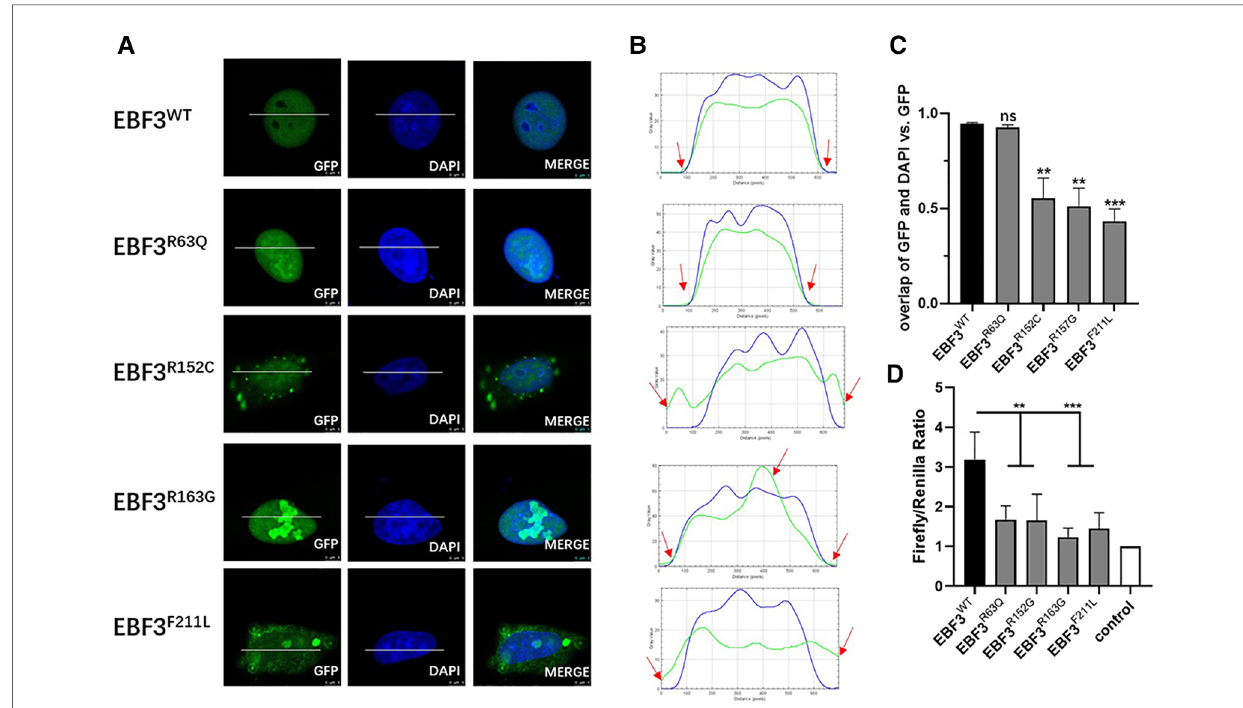
FIGURE 3 In vitro functional analysis of four novel missense variants at the cellular level. ( A ) Localization of GFP-EBF3-WT and GFP-EBF3-Mut (R63Q, R152C, R163G and F211L) in Hela cells. ( B ) Intensity pro fi les of GFP-tagged EBF3 wild-type and mutants and the DNA-binding dye, DAPI. The horizontal coordinate represents the pixels on the white lines drawn in A. The vertical coordinate represents the fl uorescence intensity of the pixel. The green curve represents the intensity pro fi le of GFP-EBF3, and the blue curve represents the intensity pro fi le of DAPI. For each condition a representative image and the corresponding intensity pro fi le plot are shown. ( C ) The Pearson ’ s correlation coef fi cient is calculated for colocalization analysis. Three representative single cell images from three individual experiments are analyzed using coloc2 (a plugin in the Fiji software) and the results are shown as mean±SD. ** p <0.01, *** p <0.001. ( D ) Dual luciferase assay results re fl ect the expression of the luciferase activated by p21 promoter bound with EBF3-R63Q, EBF3-R152G, EBF3-R163G or EBF3-F211L. Results are mean±SD for four individual experiments which were performed in triplicate for each condition. ns: not signi fi cant, ** p <0.01, *** p